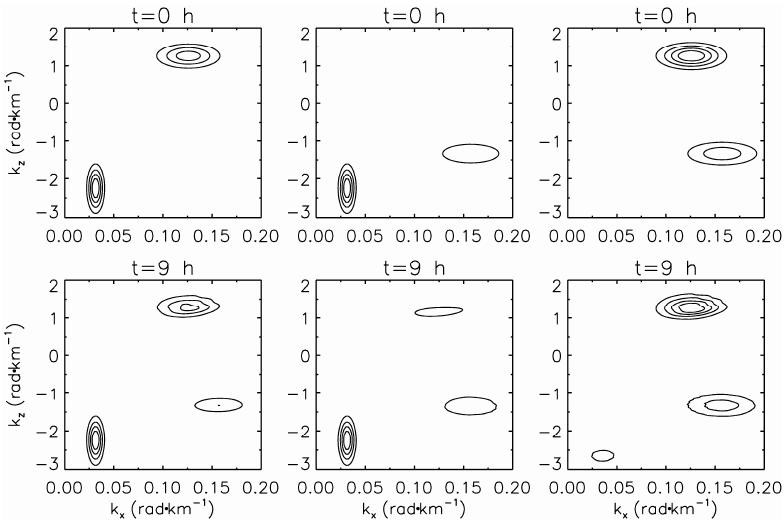
Fig. 5. Similar to Fig. 2, but for cases